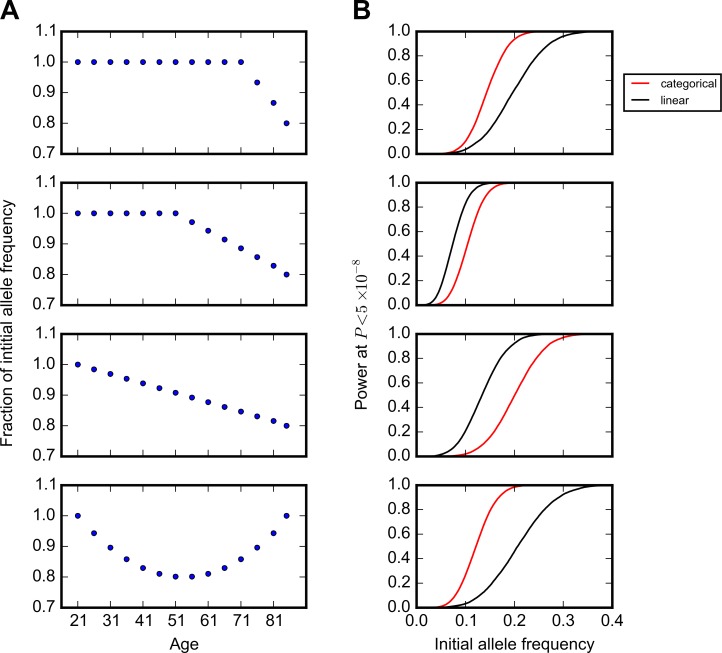
Power of the model to detect changes in allele frequency with age.(A) Trends in allele frequency with age considered in simulations. The y-axis indicates the allele frequency standardized to the frequency in the first age bin. (B) Power to detect the trends in (A) at P < 5 × 10−8, given the sample size per age bin in the Genetic Epidemiology Research on Adult Health and Aging (GERA) cohort (S2 Fig and total sample size of 57,696). Shown are results using models with age treated as a categorical (red) or an ordinal (black) variable, assuming no change in population structure and batch effects across age bins. The curves show simulation results sweeping allele frequency values with an increment value of 0.001 (1,000 simulations for each allele frequency) smoothed using a Savitzky-Golay filter in the SciPy package [43].